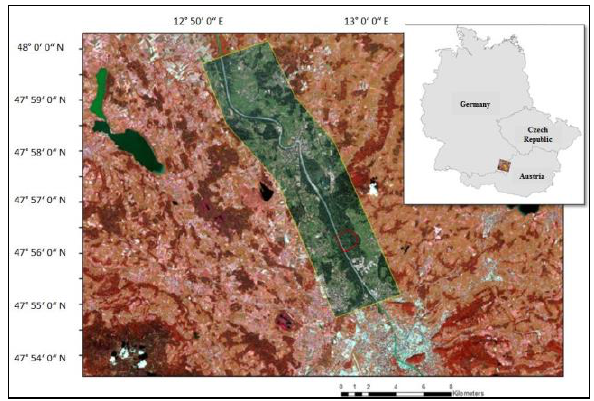
Figure 1. Salzach floodplain, located at the border of Germany and Austria. The red polygon indicates the test